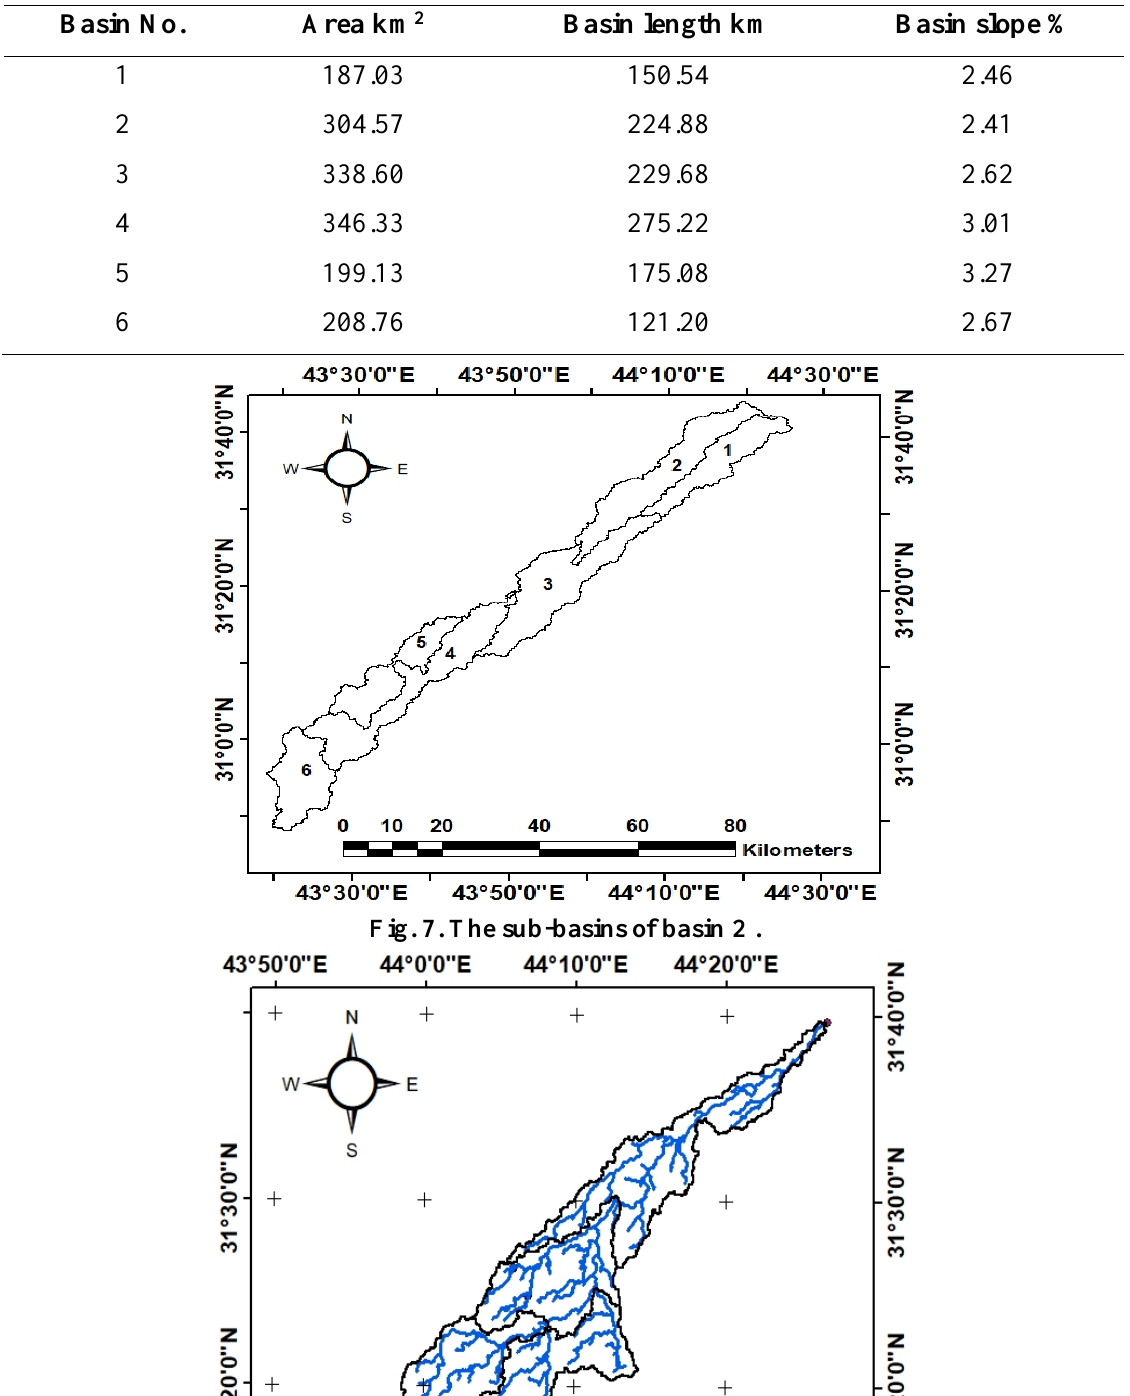
Table 3. The details of sub-basins of basin 2.